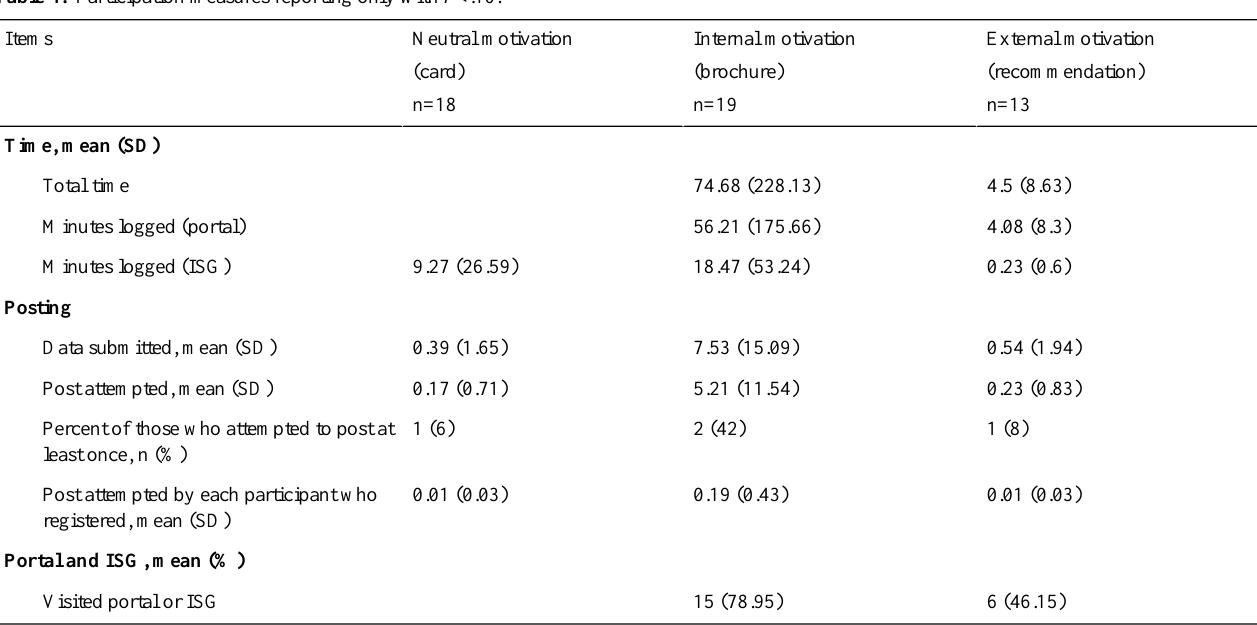
Table 4. Participation measures reporting only with P <.10.